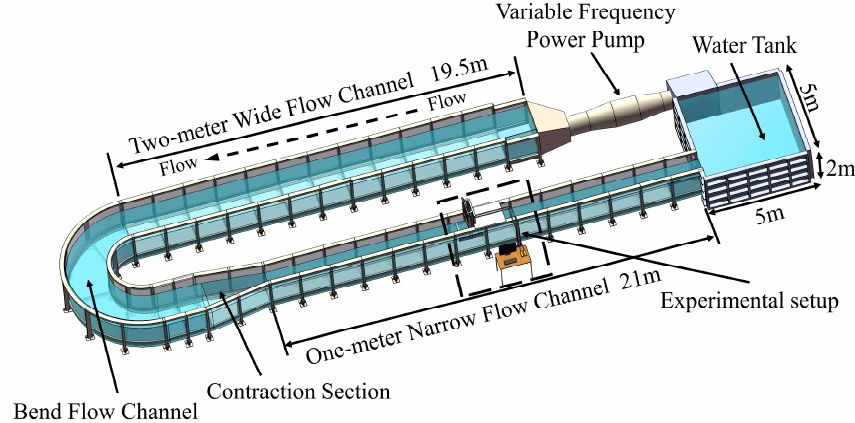
Figure 2. Recirculating water channel system .